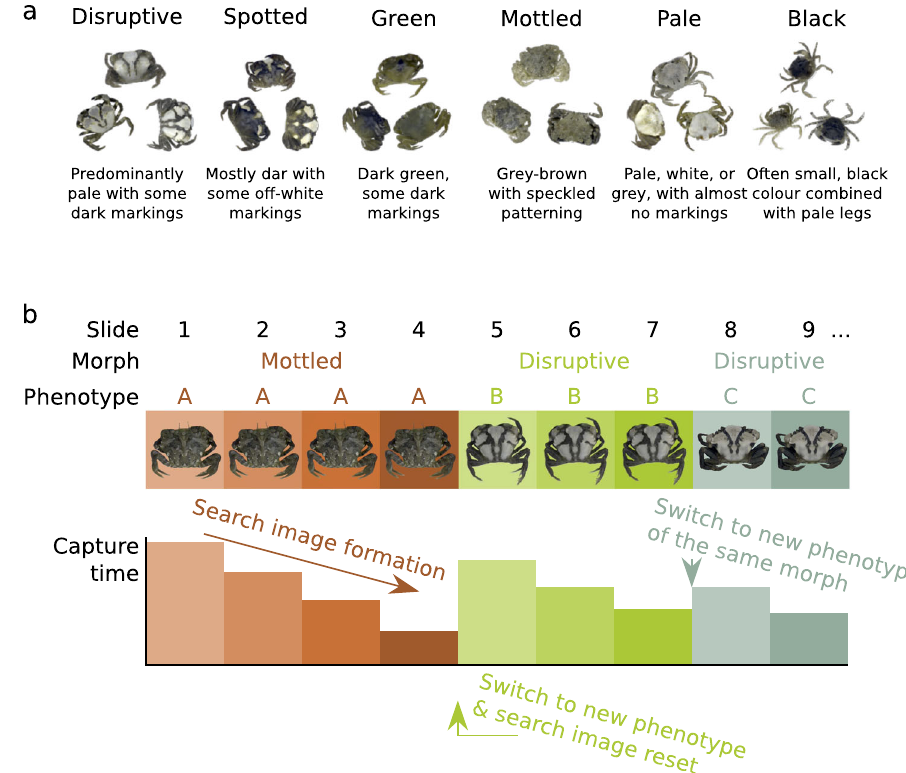
Fig. 1 Illustration of game design. a Crab categories illustrating the six phenotypic groups used in the search image game; b Illustration of the study design. This example shows the fi rst nine slides, containing two phenotype switch events (one of which also changes the